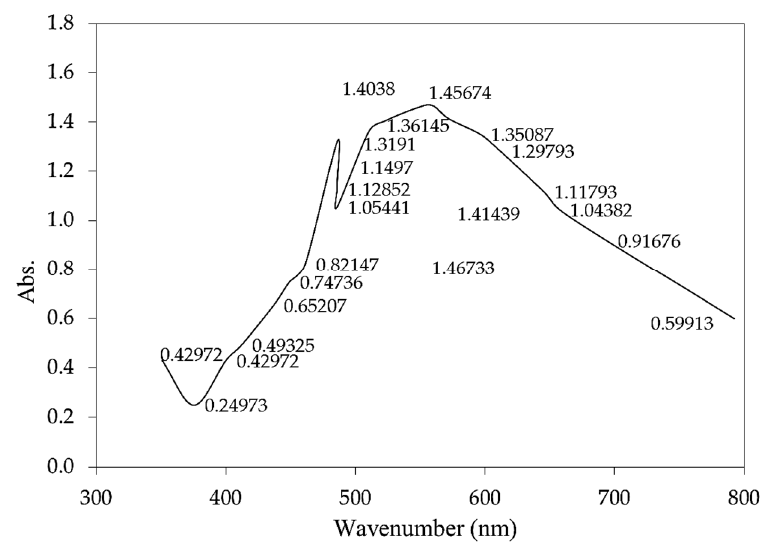
Figure 4. UV-Visible spectrum of S. linifolium extracts obtained with aqueous extract.